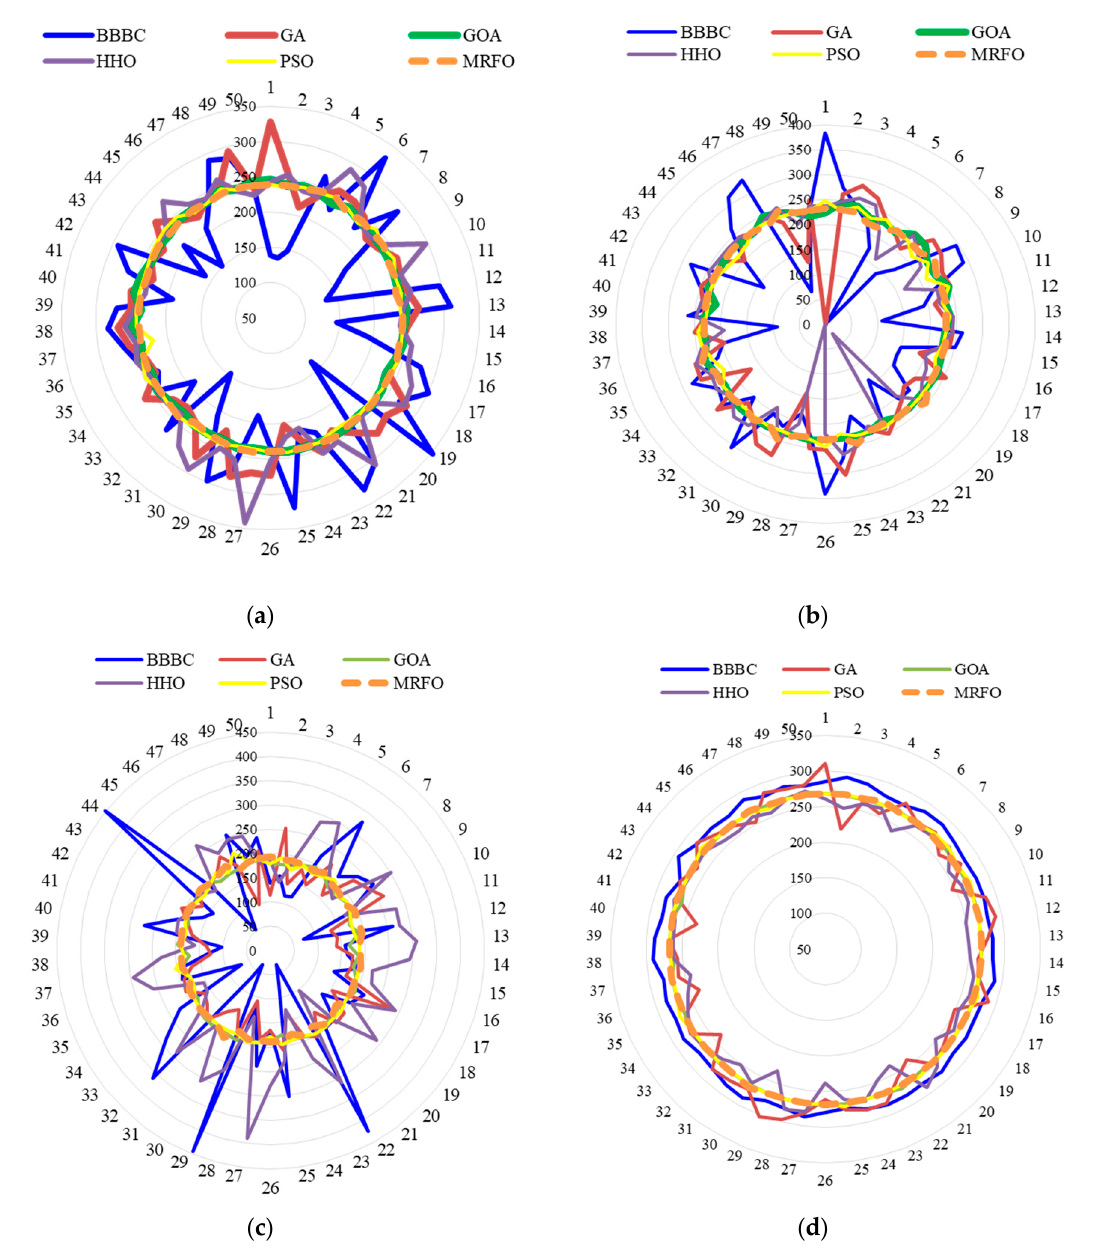
Figure 11. Optimal capacity vs. runs of: ( a ) PV, ( b ) WTG, ( c ) battery bank, and ( d ) diesel generator; using MRFO compared to the other five algorithms for LPSP = 0%.